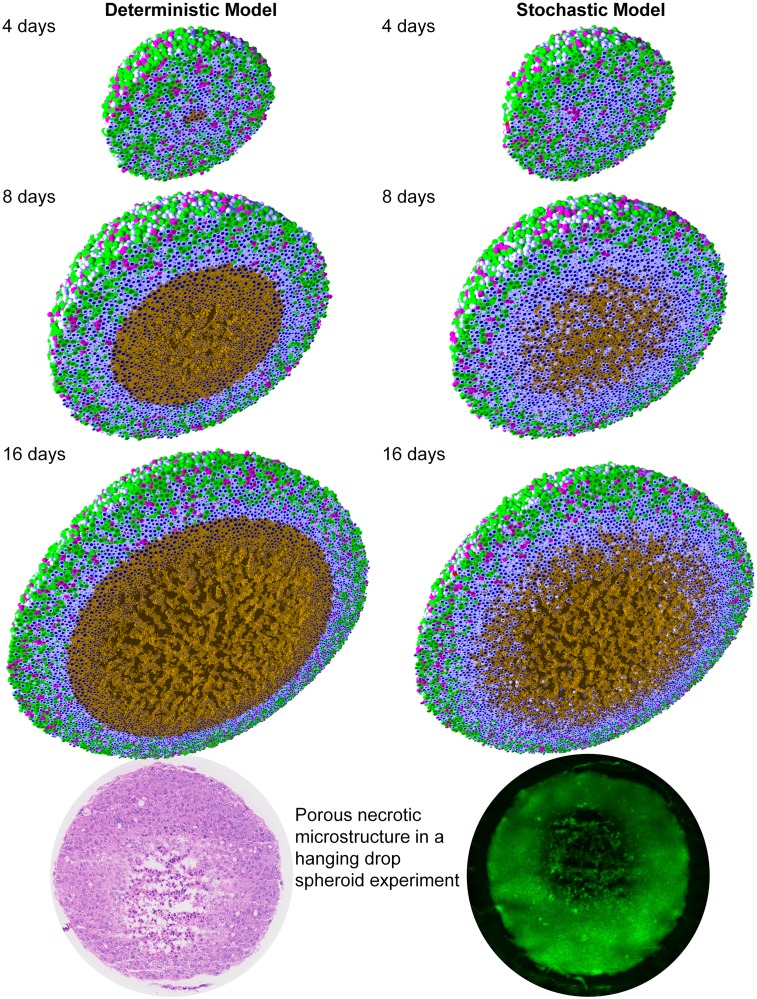
Hanging drop spheroid (HDS) simulations with deterministic necrosis (left) and stochastic necrosis (right), plotted at 4, 8, and 16 days.Videos are available at S1 and S2 Videos. Legend: Ki67+ cells are green before mitosis (K1) and magenta afterwards (K2). Pale blue cells are Ki67- (Q), dead cells are red (apoptotic) and brown (necrotic), and nuclei are dark blue. Bottom: Hanging drop spheroid experiment (HCC827 non-small cell lung carcinoma) showing a similar necrotic core microstructure. PhysiCell is the first simulation to predict this structure arising from cell-scale mechanical interactions. Image courtesy Mumenthaler lab, Lawrence J. Ellison Center for Transformative Medicine, University of Southern California.